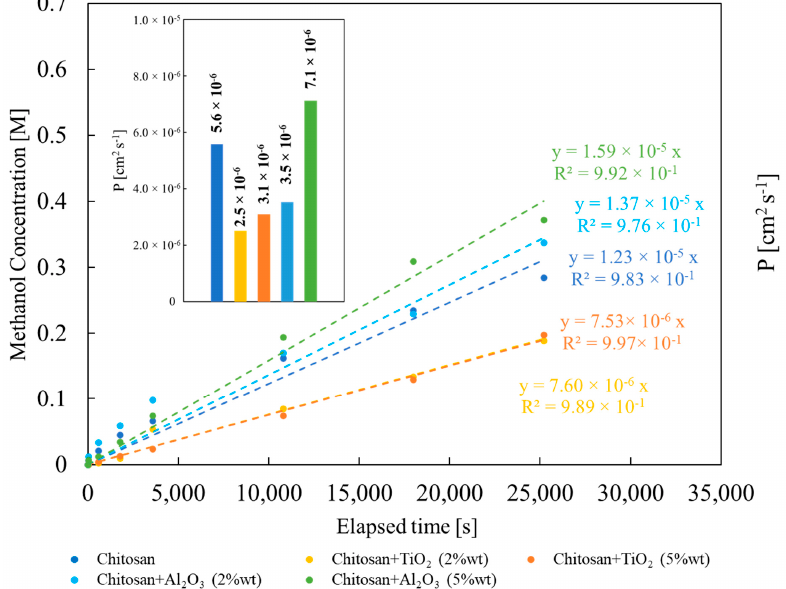
Figure 8. Methanol concentration dependence on time during methanol permeability measurements. Inset: methanol permeability values estimated according to Equation (4).